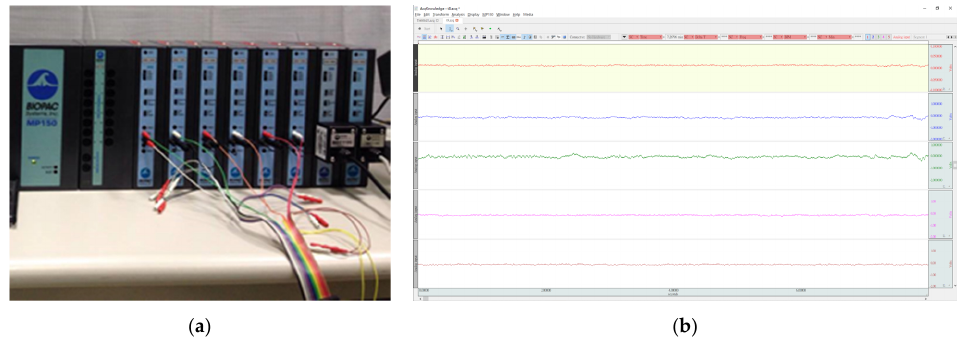
Figure 5. Bio-physiological characteristic information collection equipment MP150 ( a ) Biopac MP-150 and EEG and ECG physiological signal amplifier host; ( b ) ACQKNOWLEDGE physiological signal capture record and analysis software, Schematic diagram of physiological signal measure- ment.